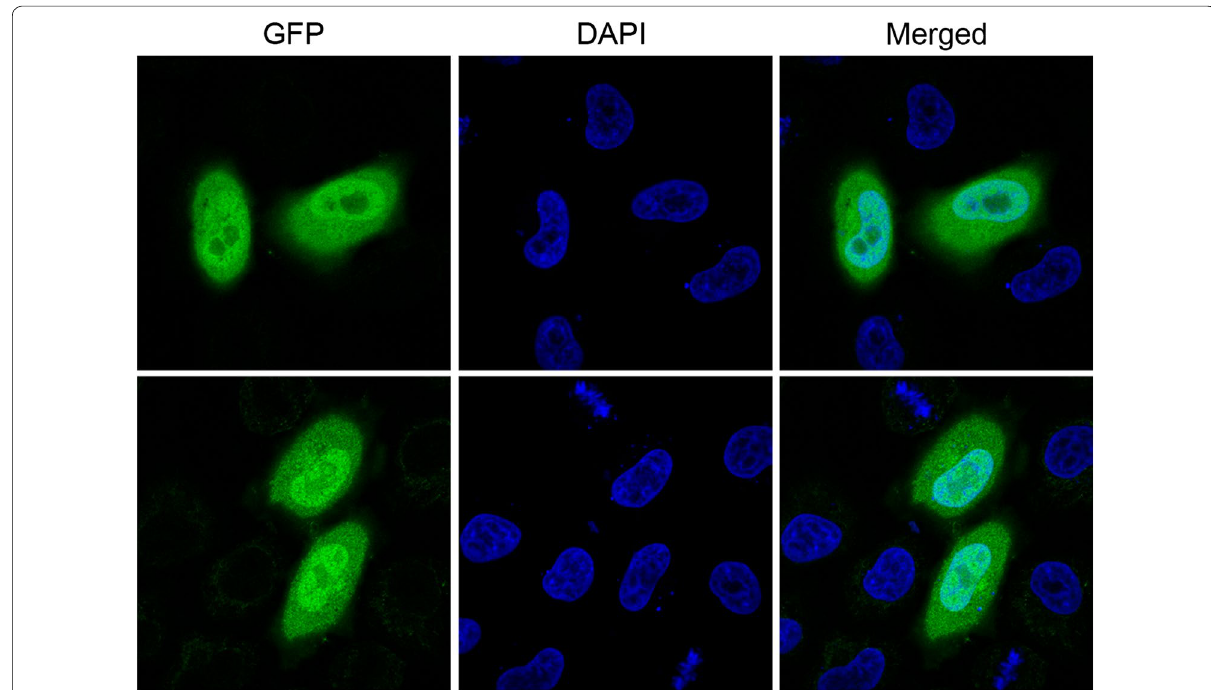
Fig. 4 Expression of EGFP cloned in pOmni in HeLa cell. Confocal laser scanning microscopy showed that EGFP cloned in pOmni was strongly expressed in transfected HeLa